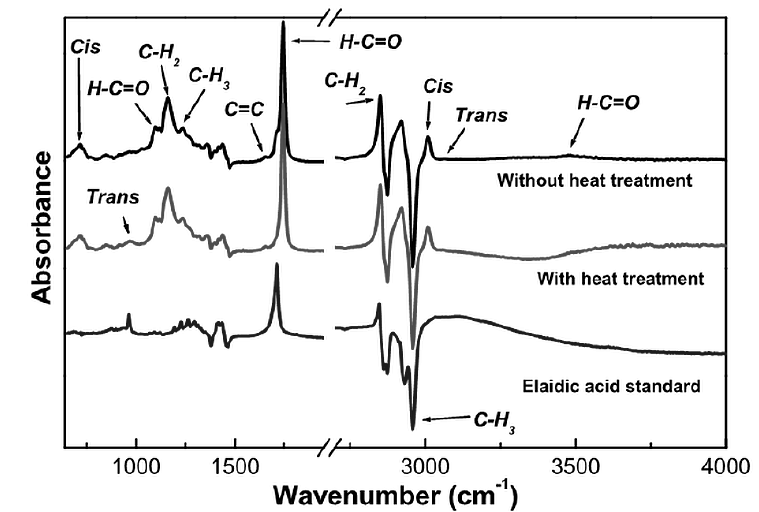
Figure 1. FTIR spectra of the amaranth oils and of the elaidic acid